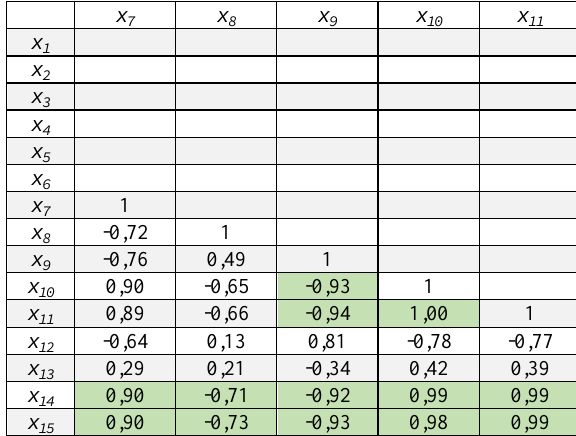
Table 2. Correlation coefficient (continuation)